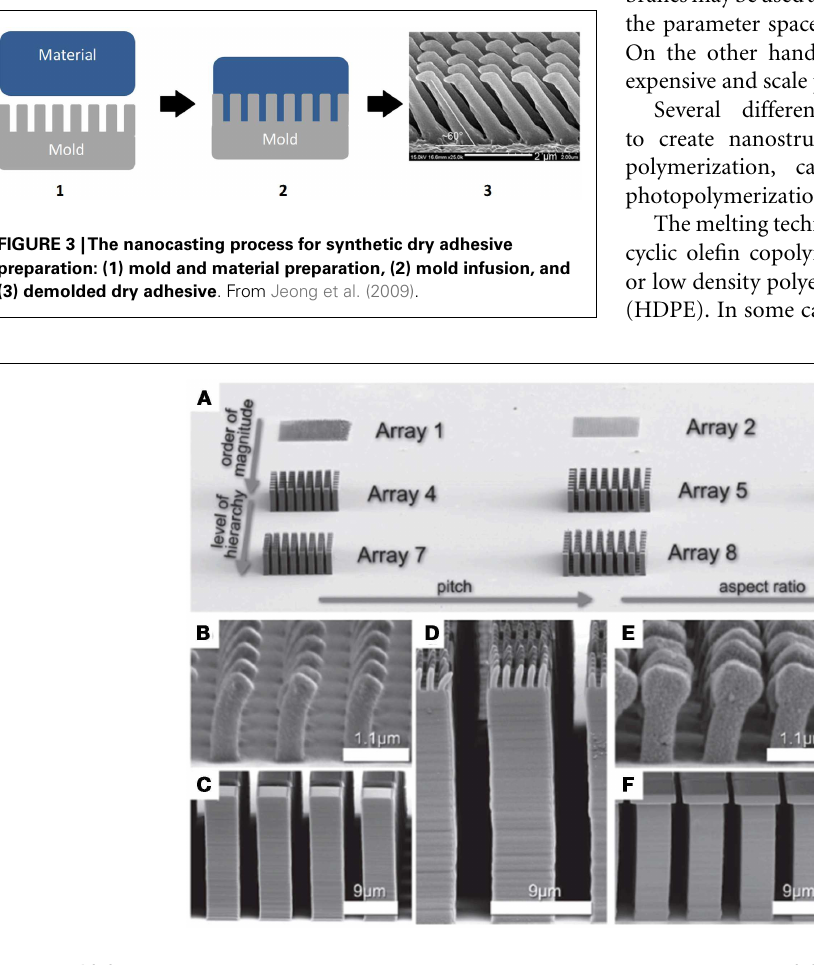
FIGURE 4 | (A) Several gecko-inspired arrays fabricated by 3D direct laser writing. (B) SEM image of array 1, which contains small single level structures with a width of 500nm. (C) The SEM image shows array 4, which contains